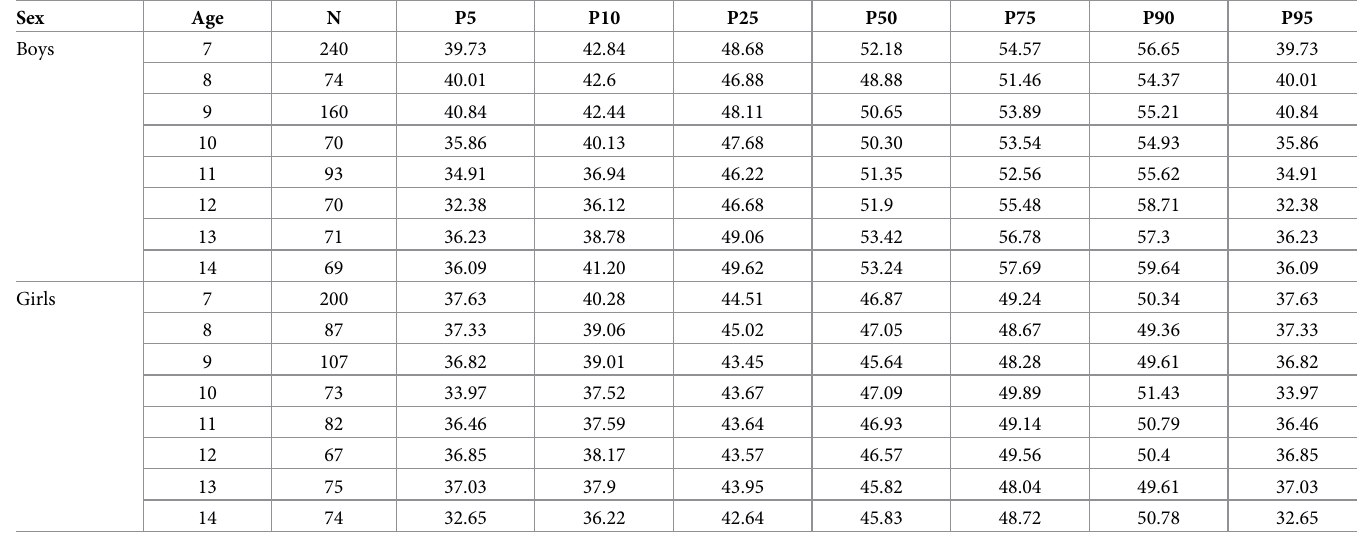
Table 4. Sex- and age-specific normative reference values for the VO 2 max (ml/kg/min; N = 1,612).